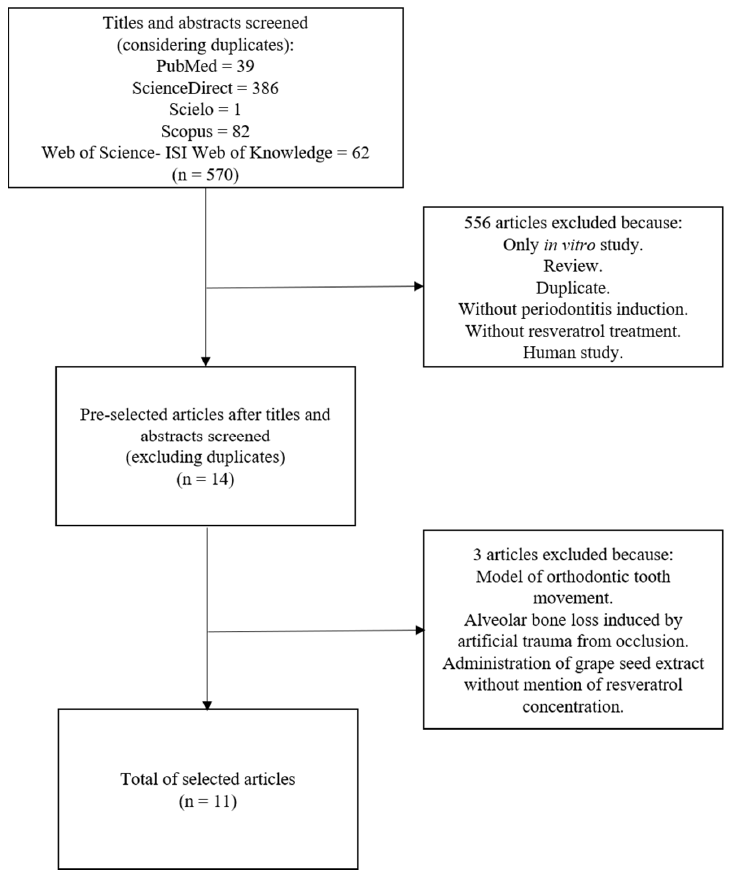
Figure 1. A flowchart of the studies selection.